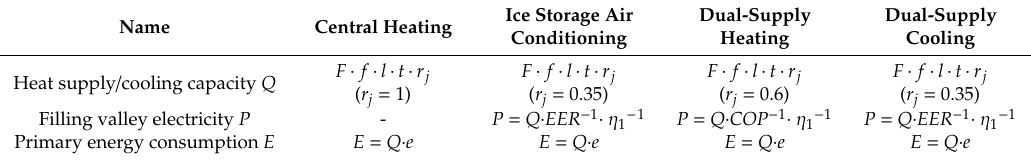
Table 3. Energy consumption and cost calculation for di ff erent cooling and heating